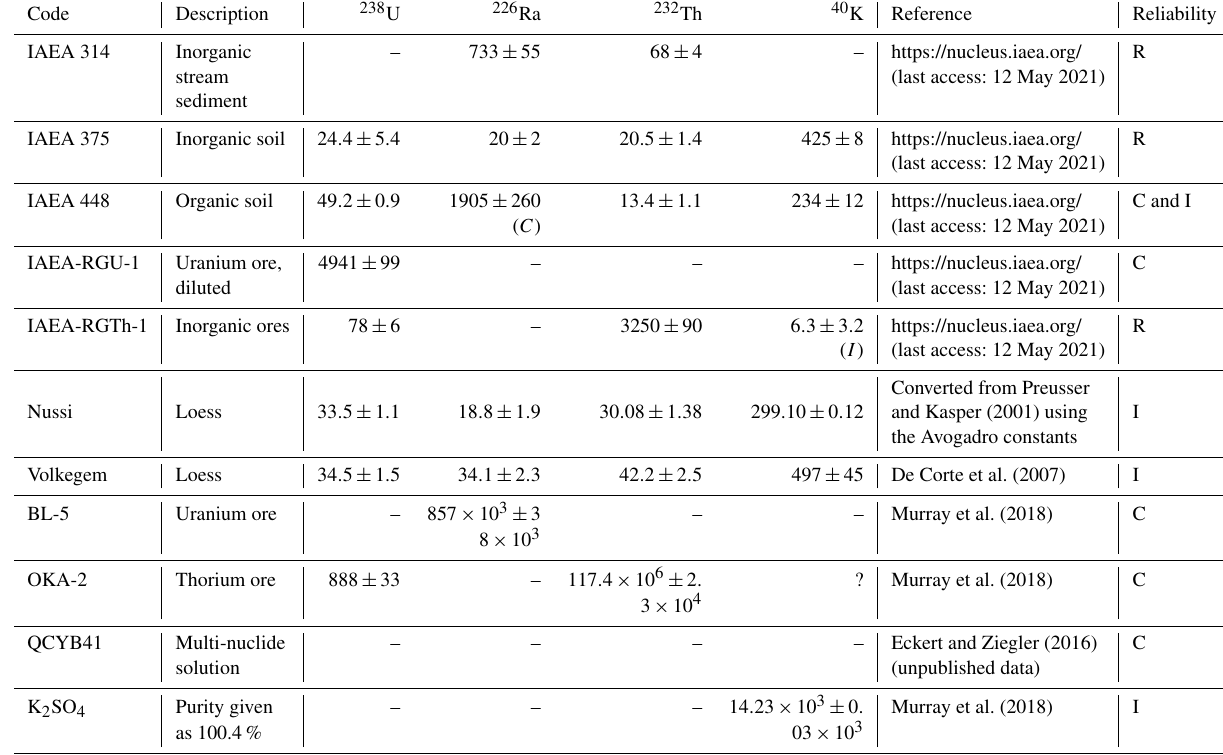
Table C2. Reference material commonly used for efficiency calibration. Activities are given in Bqkg − 1 . R: recommended; C: certified; I: